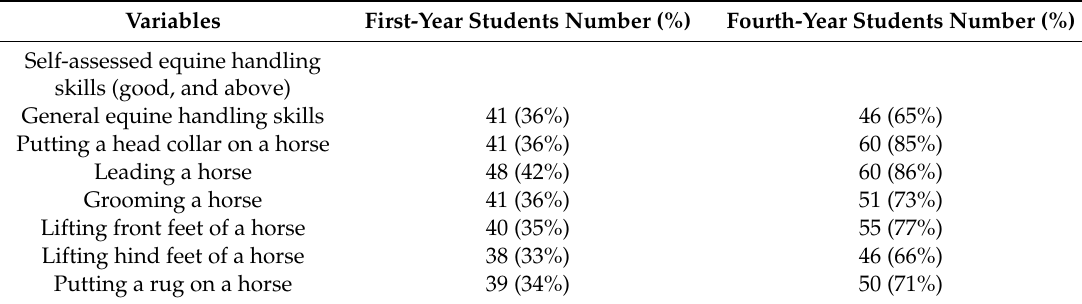
Table 5. Number and percentage of first-(n = 115 / 186) and fourth-year (n = 71 / 186) veterinary students and their self-assessed level of equine handling